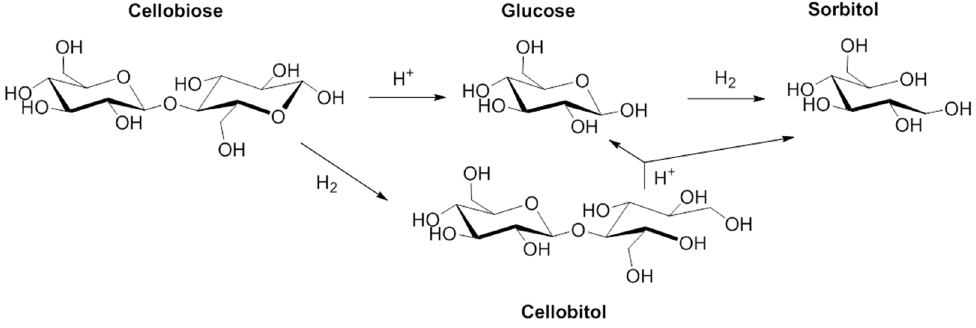
Figure 4. Reaction pathways for cellobiose conversion to sorbitol.